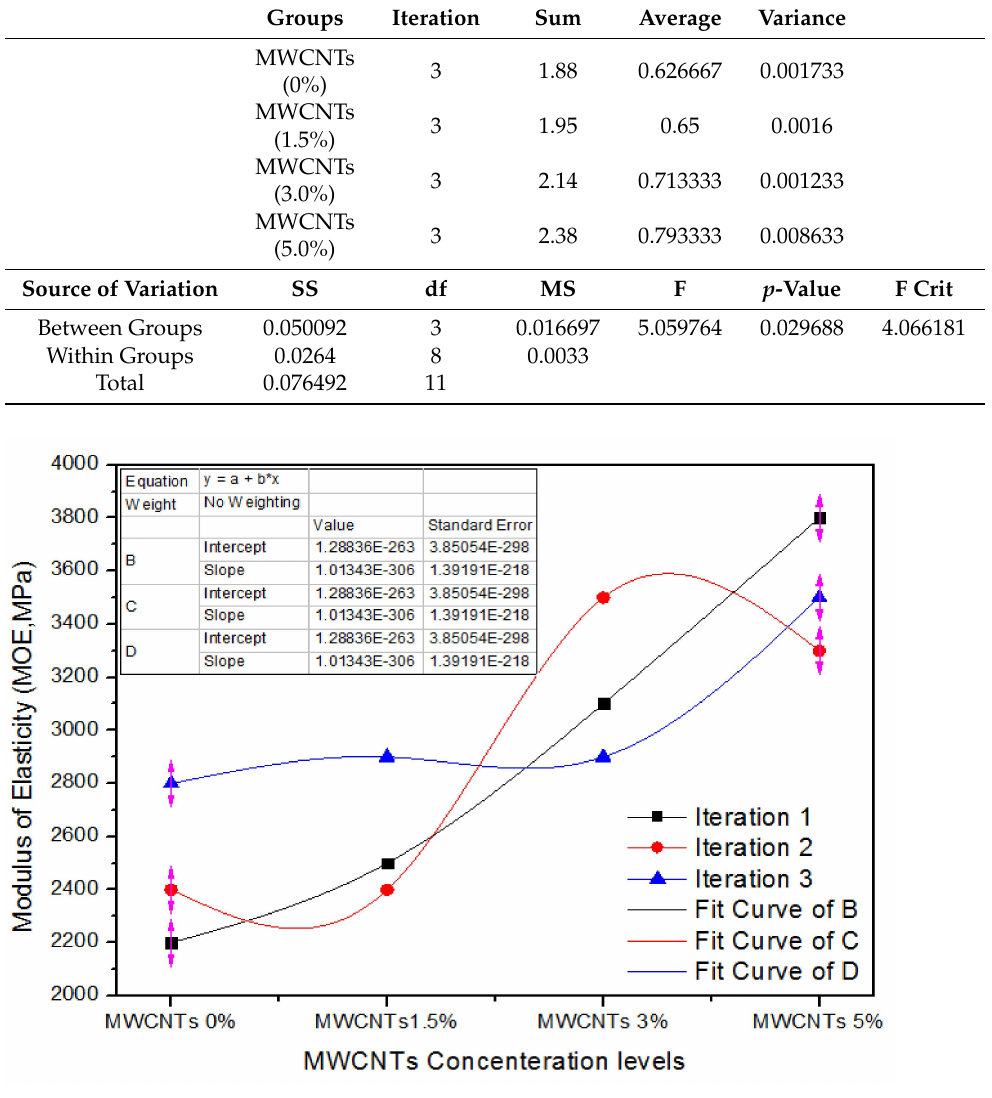
Figure 13. Numerical values of modulus of elasticity (MOE) of various treatments of